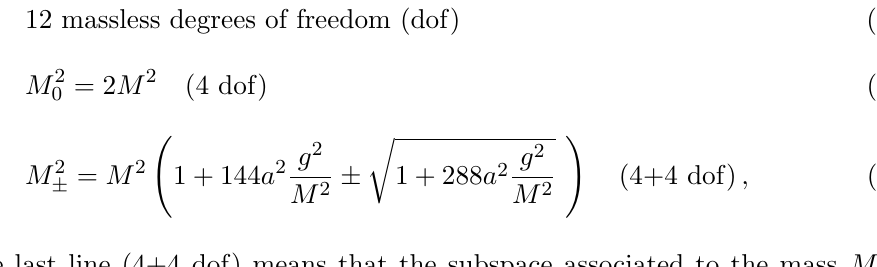
Figure 1 . Graph of the three types of scalar masses of the SU(3) model. This graph is relevant for the other models too since all the masses are of the form M 2 being linear combinations of the vacuum parameters. We can see that M 2 (cid:11) i while the two other masses remain around the M 2